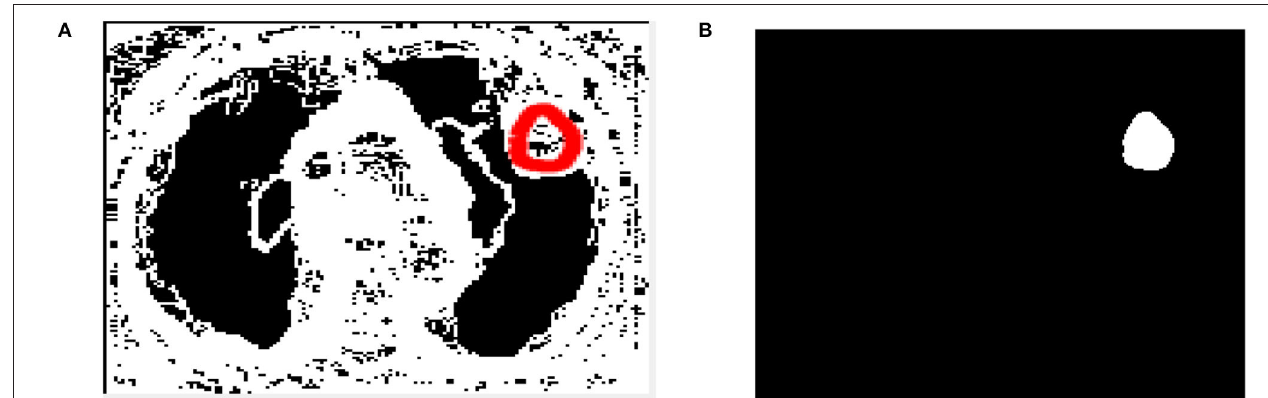
FIGURE 4 | (A) Extracted output. (B) Segmented output. is to be split up into smaller portions in the pooling layer and for each portion, the maximum value is selected and then accomplished in some process for each portion